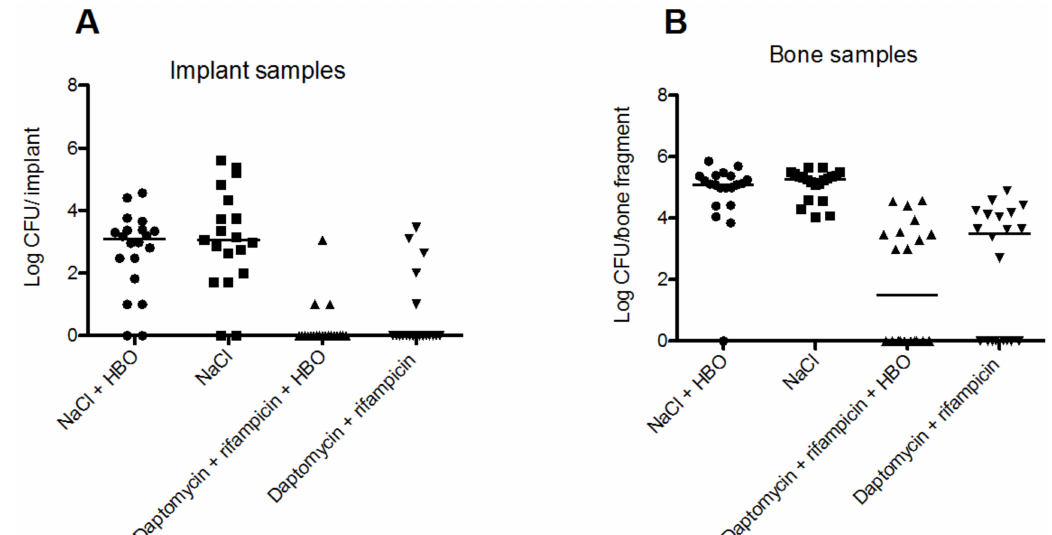
Figure 2. A: Median bacterial load of implants for NaCl group was 3.06 (0.0–5.59) log colony forming units (CFU)/implant (median, range), while the NaCl + HBOT group had a bacterial load of 3.08 (0.0–4.56) log CFU/implant, which was not significantly lower (group n -value = 20, p = 0.54, Mann–Whitney test). Median bacterial load for daptomycin + rifampicin was 0.0 (0.0–3.46) log CFU/implant, which was no different than for daptomycin + rifampicin + HBOT, 0.0 (0.0–3.06) log CFU/implant (group n -values = 20, p = 0.37, Mann Whitney test). In total, 17/20 (85%) and 15 (75%) of the implants in the daptomycin + rifampicin + HBOT and daptomycin + rifampicin groups, respectively, were without growth. There was no significantly difference in cure rates between the two treatment groups (group n -value = 20, p = 0.685, Fisher’s exact test). Both treatments resulted in a significant reduction of bacterial load compared to both NaCl or NaCl + HBOT ( p < 0.0001, Mann Whitney test). B: Infected bones of the NaCl-treated animals had a bacterial load of 5.27 (4.03–5.88) log CFU/bone (median, range), while the NaCl + HBOT group had a median load of 5.1 (0.0–5.86) log CFU/bone, which was not statistically different from NaCl-treated animals ( n -value = 20, p = 0.34, Mann–Whitney test). Daptomycin + rifampicin treatment eradicated infection in 8/20 samples (40%) and the median bacterial load in uncured bones was 3.51 (0.0–4.89) log CFU/bone, while daptomycin + rifampicin + HBOT eradicated infection in 10/20 samples (50%) and reduced the bacterial load in the uncured bones to 1.5, (0.0–4.59) log CFU/bone. There was no difference in “cure rate” ( p = 0.751, Fisher’s exact test) or in mean bacterial load ( p = 0.31, Mann Whitney